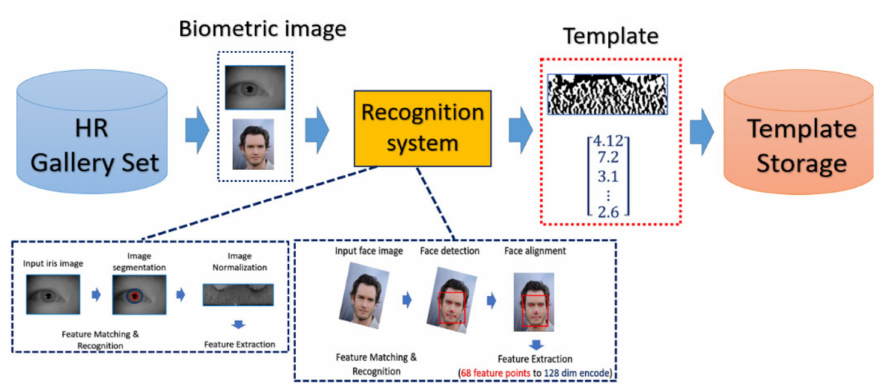
Figure 6. The flow chart of biometric template enrollment stage.